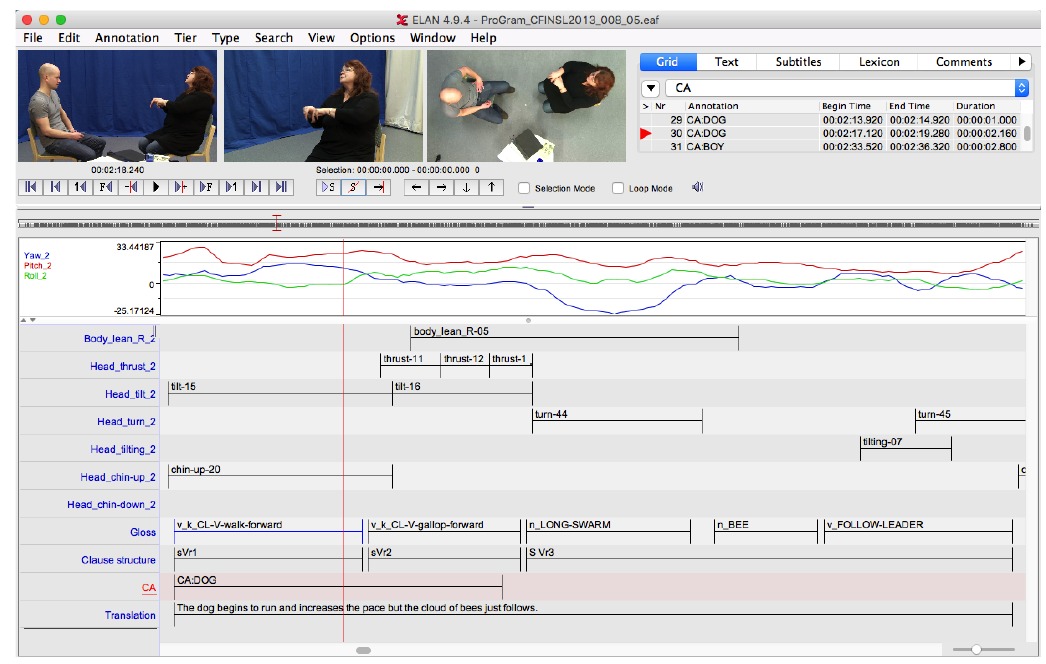
Figure 2. ELAN screenshot showing the video from three angles, the computer-vision based descriptors for head movements (the time series panel), and annotations (the